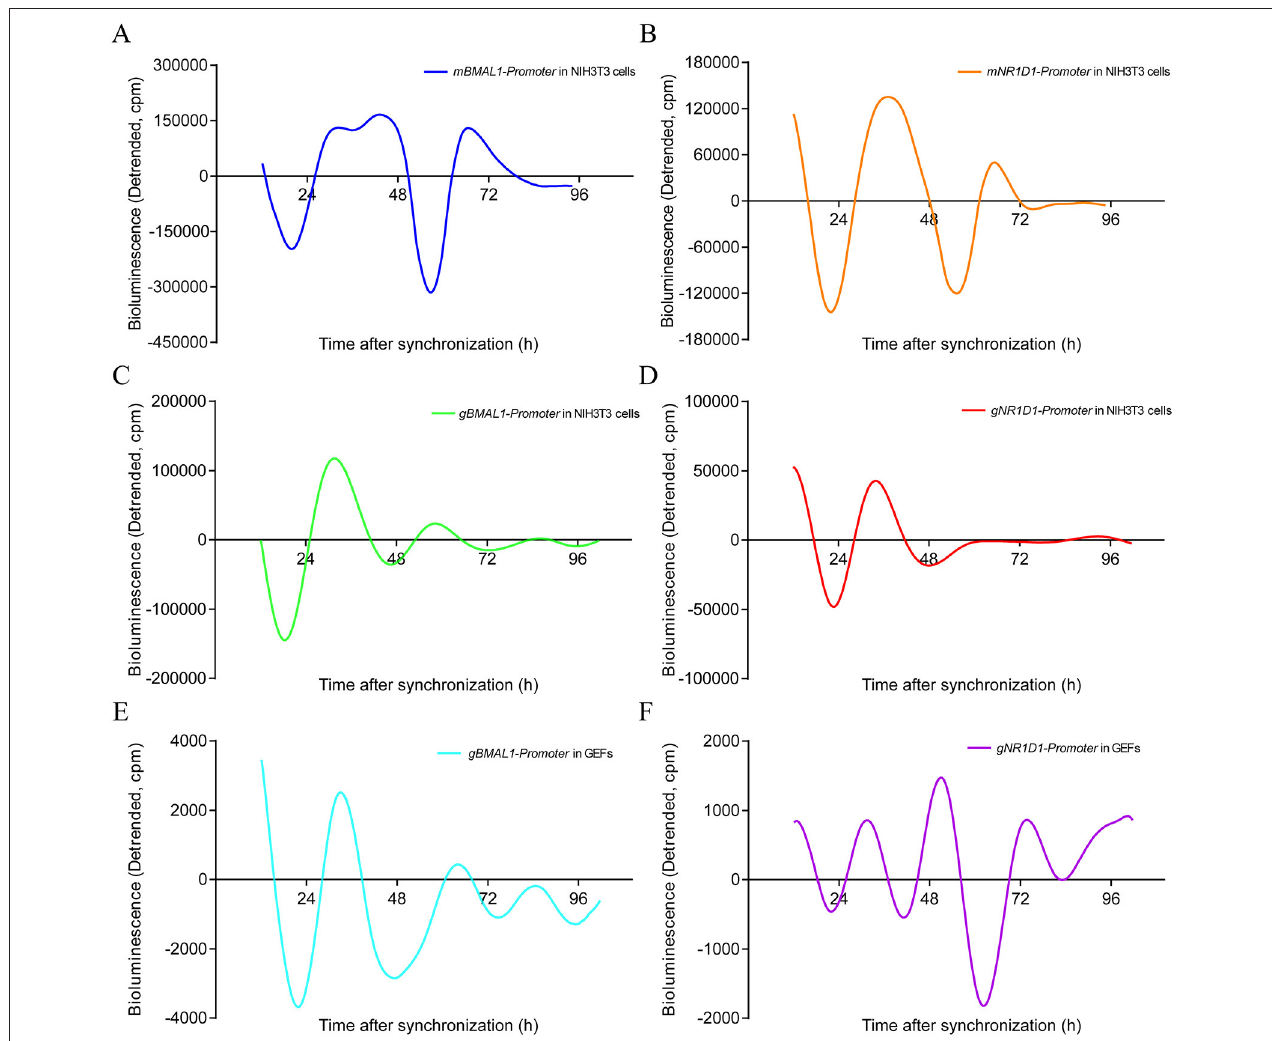
FIGURE 8 | Real-time luciferase assays in NIH3T3 cells or GEFs with two different promoters of mouse and goat. Representative records of bioluminescence from NIH3T3 cells transfected with pGL4.22-mBMAL1-Promoter- Luc (A) or pGL4.22-mNR1D1-Promoter- Luc (B) . Representative records of bioluminescence from NIH3T3 cells transfected with pGL4.22-gBMAL1-Promoter- Luc (C) or pGL4.22-gNR1D1-Promoter- Luc (D) . Representative records of bioluminescence from GEFs transfected with pGL4.22-gBMAL1-Promoter- Luc (E) or pGL4.22-gNR1D1-Promoter- Luc (F) . Representative results from three independent repetitions are shown. GEFs, goat embryonic